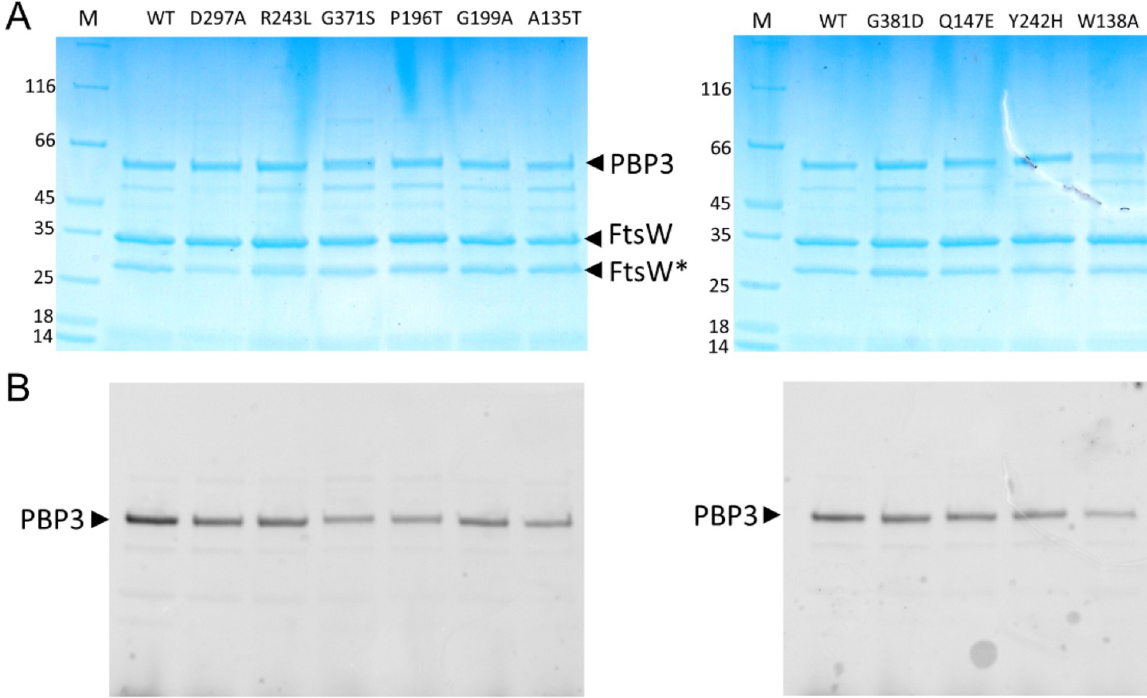
Fig 9. Purification of FtsW variants in a complex with FtsI/PBP3. FtsW and FtsI/PBP3 were co-expressed in E . coli cells; FtsW contains a His- Tag and was used as bait to co-purify untagged FtsI/PBP3 on a HisTrap column. The samples were incubated with Bocillin FL to label FtsI and analyzed by SDS-PAGE. The gels were first subjected to fluorescence imaging to detect Bocillin-bound FtsI/PBP3 (B) followed by Coomassie blue staining (A). The positions of FtsW and FtsI/PBP3 are indicated by arrows and FtsW mutations are shown on top of each lane of the gel. FtsW � indicates an FtsW degradation product. M, protein standards.